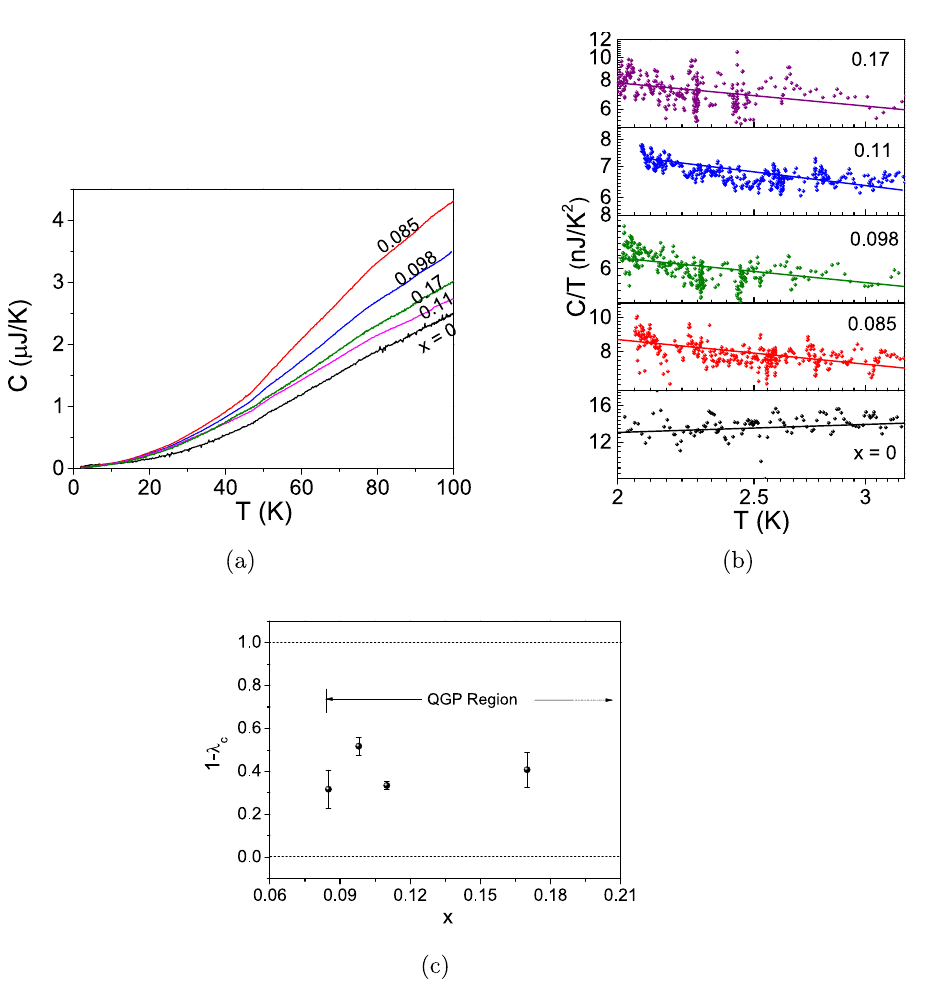
Figure 8. ( a ) C − T plots in the temperature range 2 K–230 K for x = 0.000, 0.085, 0.098 and 0.11. ( b ) Log-log plots of C / T versus T (symbols) in low-T (2 K–3.5 K) range for various x values, and their linear fits (solid lines). ( c ) Plot of (1 − λ C ) versus x . The prospective QGP region is